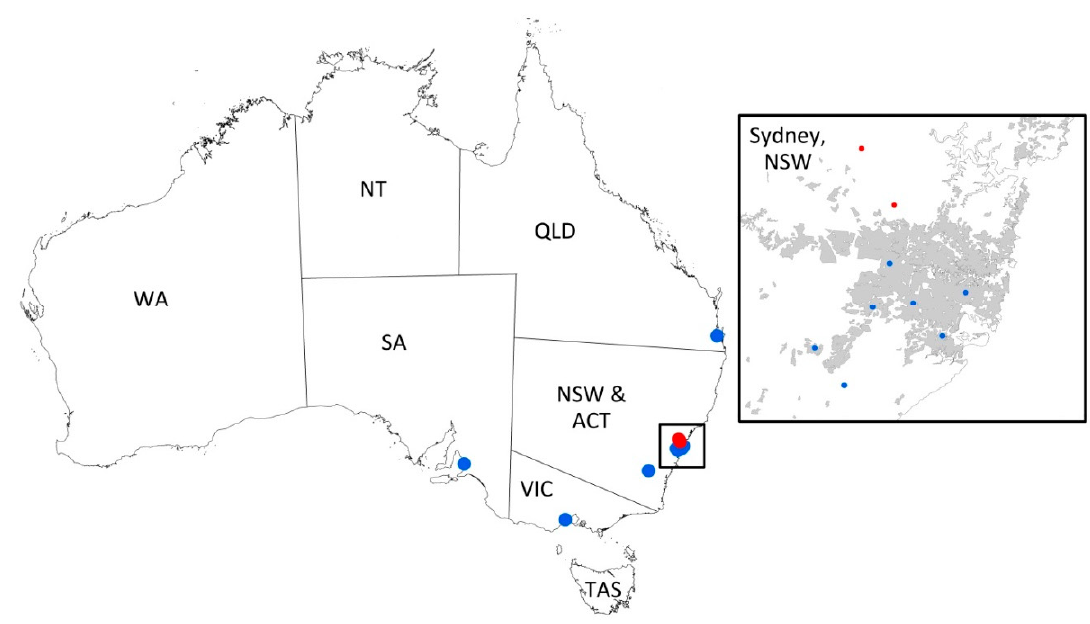
Figure 1. Map of Australia, showing the location of the veterinary hospitals (Group 1; blue dots) used to recruit cats from all Australian States and Territories except WA, NT, and TAS, and the location of the two rescue facilities in Sydney, NSW (Groups 2 and 3; red dots). An enlargement of Sydney and its surrounding areas is shown in the breakout box. The grey shading in the breakout box represents the ‘Built Up Areas’ of Sydney (as defined by Geosciences Australia, http: // www.ga.gov.au / mapspecs / 250k100k / appendixA_files / Habitation.html#Habitation Built Up Area Polygon) and is included to show the semi-rural location of the two rescue facilities and one veterinary hospital on the outskirts